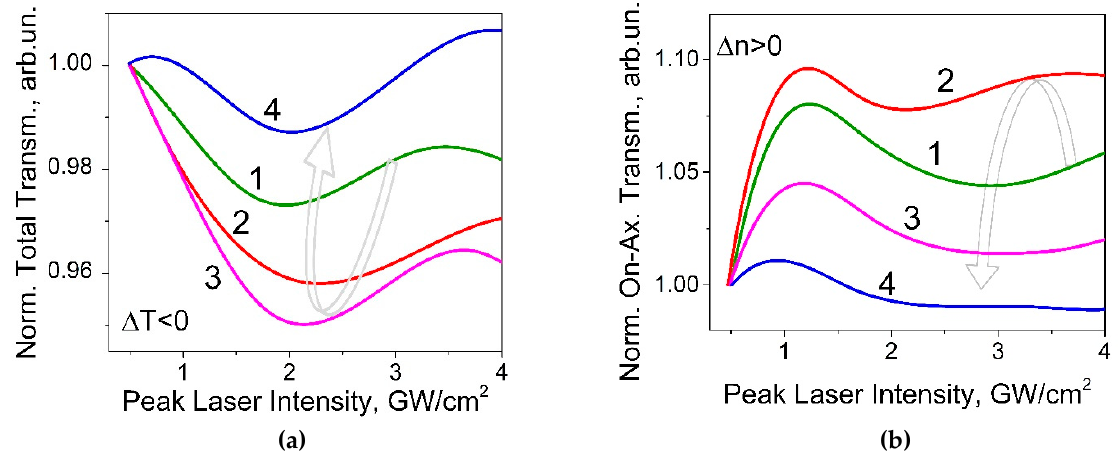
Figure 3. The photoinduced variations of the normalized total ( a ) and on-axis ( b ) transmittances versus the peak laser intensity of picosecond laser pulses at 1064 nm for the samples of P(VDF-TrFE) copolymer with different thickness: (1)—1 µm, (2)—1.2 µm; (3)—1.3 µm; (4)—1.5 µm.